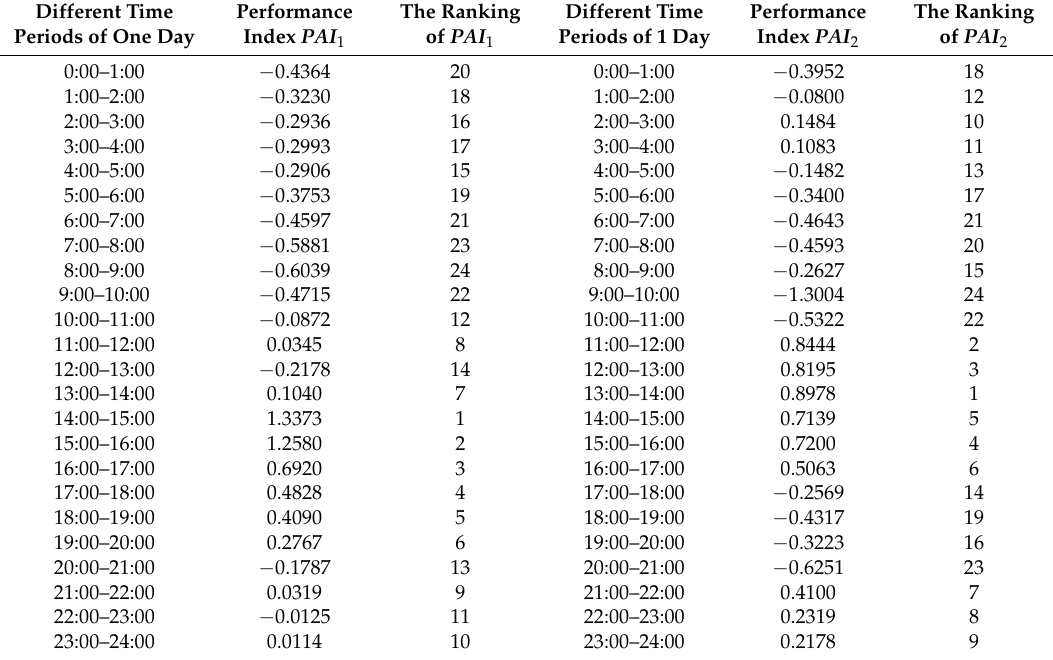
Table 5. The performance index values and rankings for 1# and 2# boiler combustion process within one day (PAI: Performance Assessment